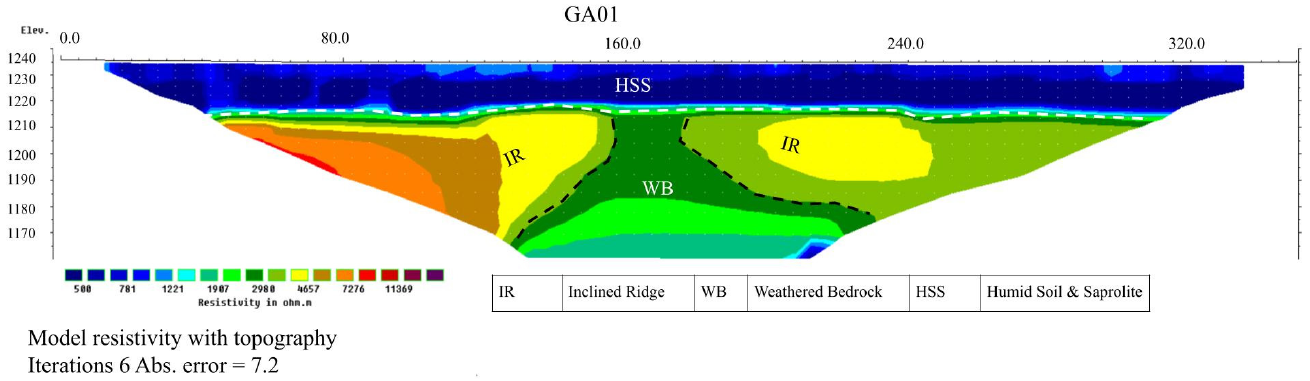
Figure 12. 2D resistivity models in the region of Brasilia using the dipole-dipole array.